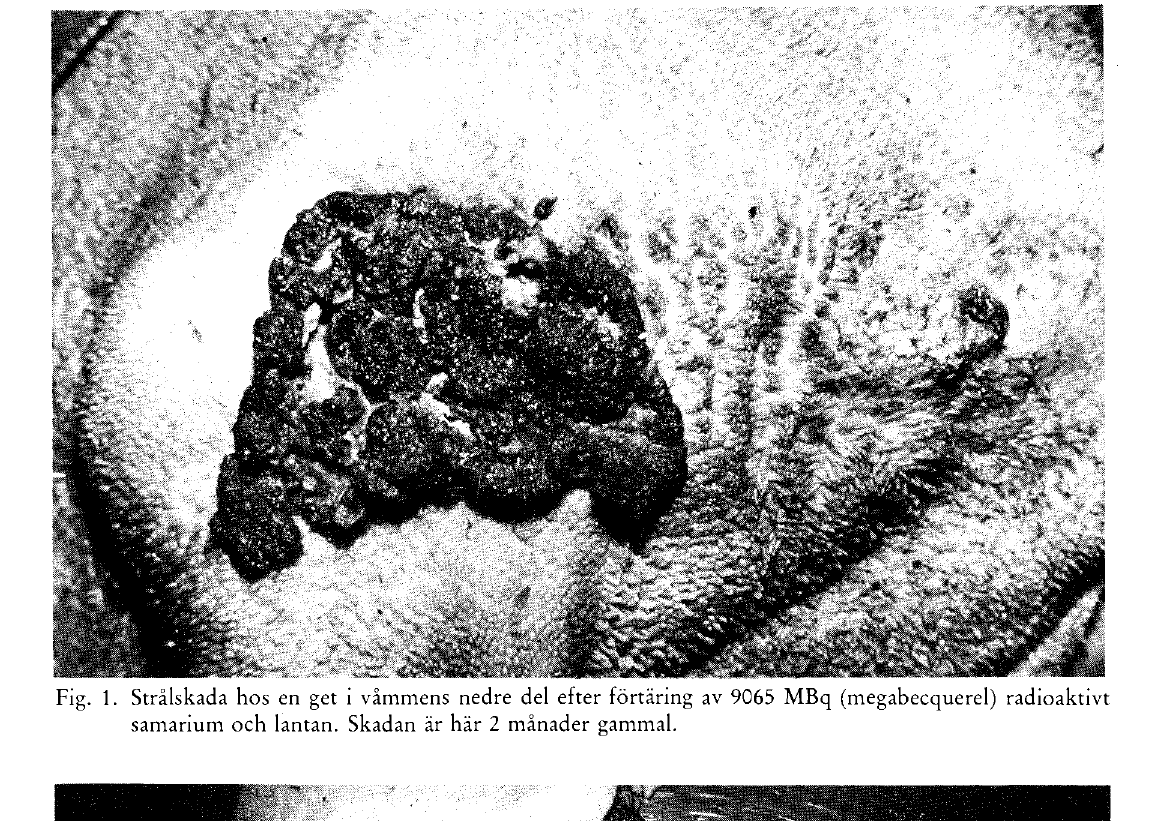
Fig. 1. Strålskada hos en get i våmmens nedre del efter förtäring av 9065 MBq (megabecquerel) radioaktivt Samarium och lantan. Skadan är här 2 månader gammal.